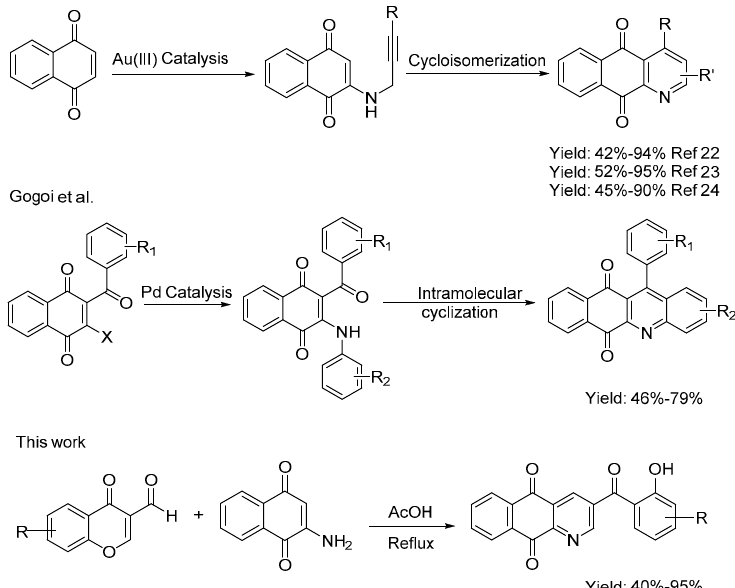
Figure 2. Di ff erent strategies to synthesize 1-aza-anthraquinone Figure 2. Different strategies to synthesize 1-aza-anthraquinone derivatives.